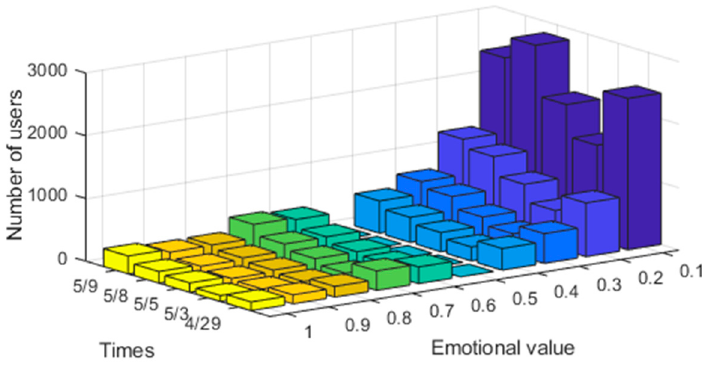
Figure 3. Distribution of emotional value for “Hive Box charges”.